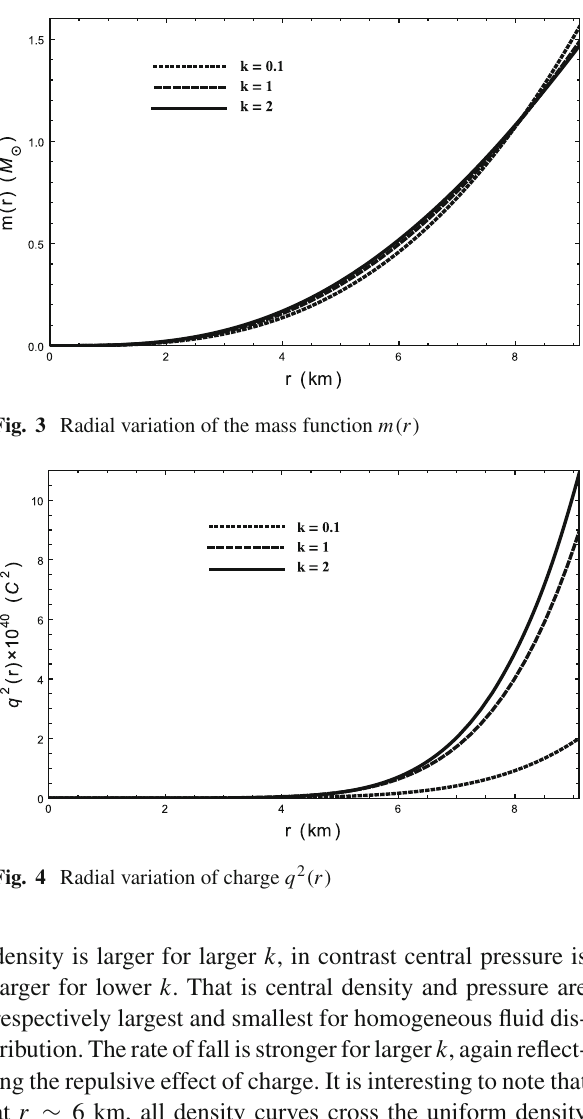
density is larger for larger k , in contrast central pressure is larger for lower k . That is central density and pressure are respectively largest and smallest for homogeneous fluid dis- tribution. The rate of fall is stronger for larger k , again reflect- ing the repulsive effect of charge. It is interesting to note that at r ∼ 6 km, all density curves cross the uniform density straight line downwards. This clearly indicates that homo- geneous distribution has the largest density at the boundary. On the other hand, mass and charge as expected